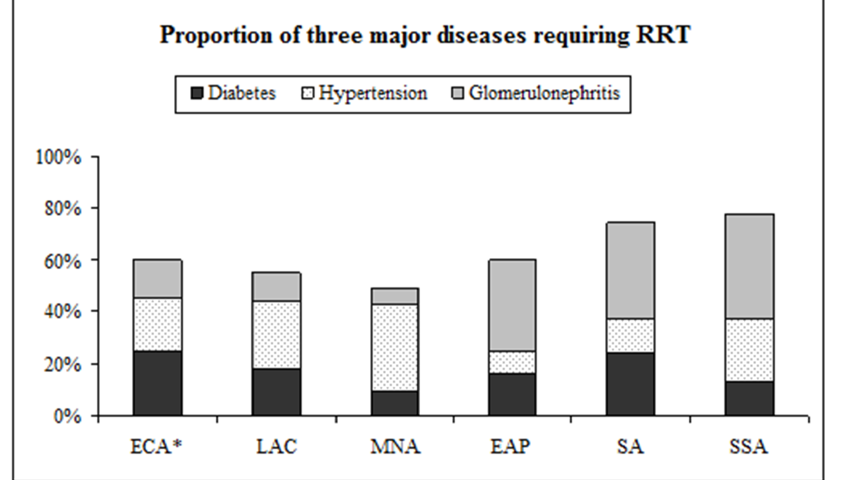
Figure 4. Proportion of diabetes, hypertension and glomerulonephritis among patients undergoing RRT. Data for ECA are from registry data representing 60% of its population; for all other developing regions, data are from the most populous country within the region. Abbreviations: HD-Hemodialysis, PD-Peritoneal dialysis, ECA-Eastern Europe and Central Asia, LAC-Latin America and Caribbean, MNA-Middle East and North Africa, EAP-East Asia and Pacific, SA-South Asia and SSA-Sub-Saharan Africa.